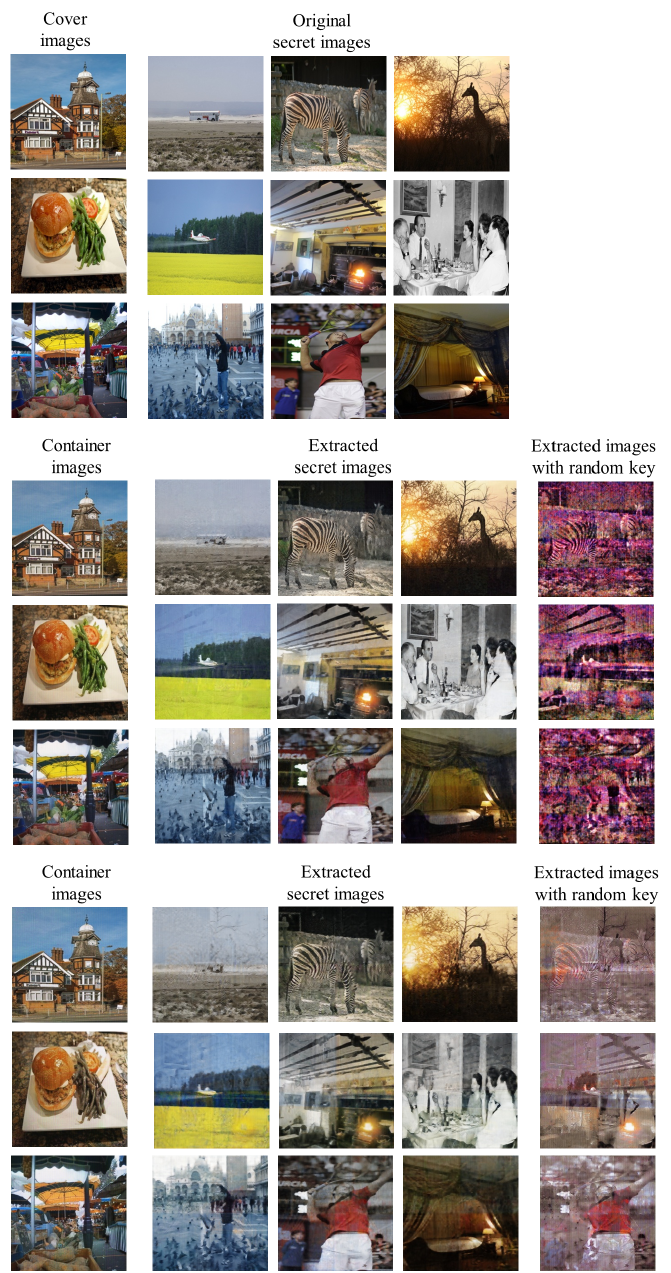
Figure 3. Qualitative Results of our steganography model when N = 3. Two types of key size were tested. The three examples above are the original cover and secret images. The three examples middle are the results of using K p , and the three examples below are the results of using K l